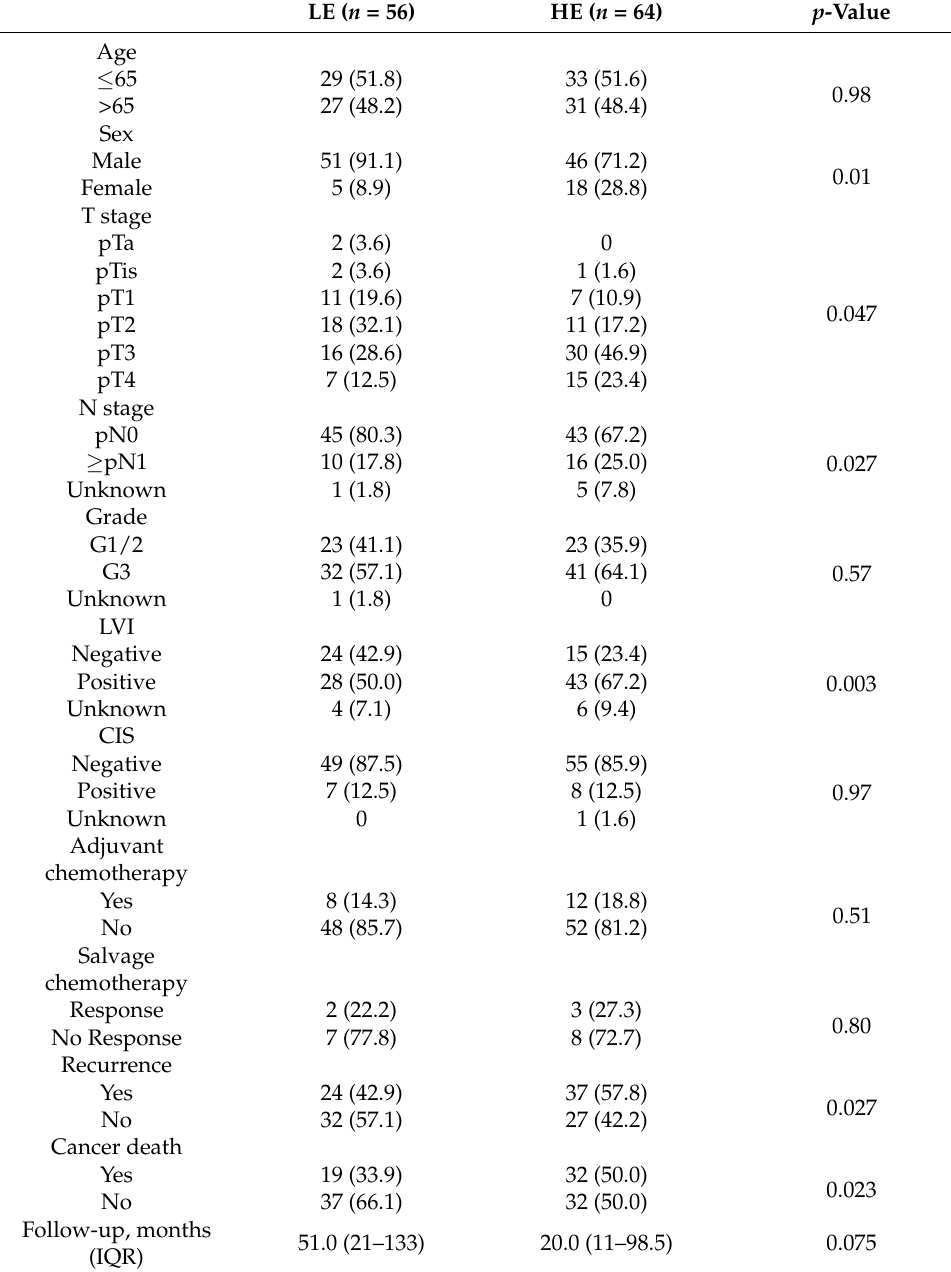
Table 1. Comparison of clinical and pathological characteristics of patients with either low or high expressions of